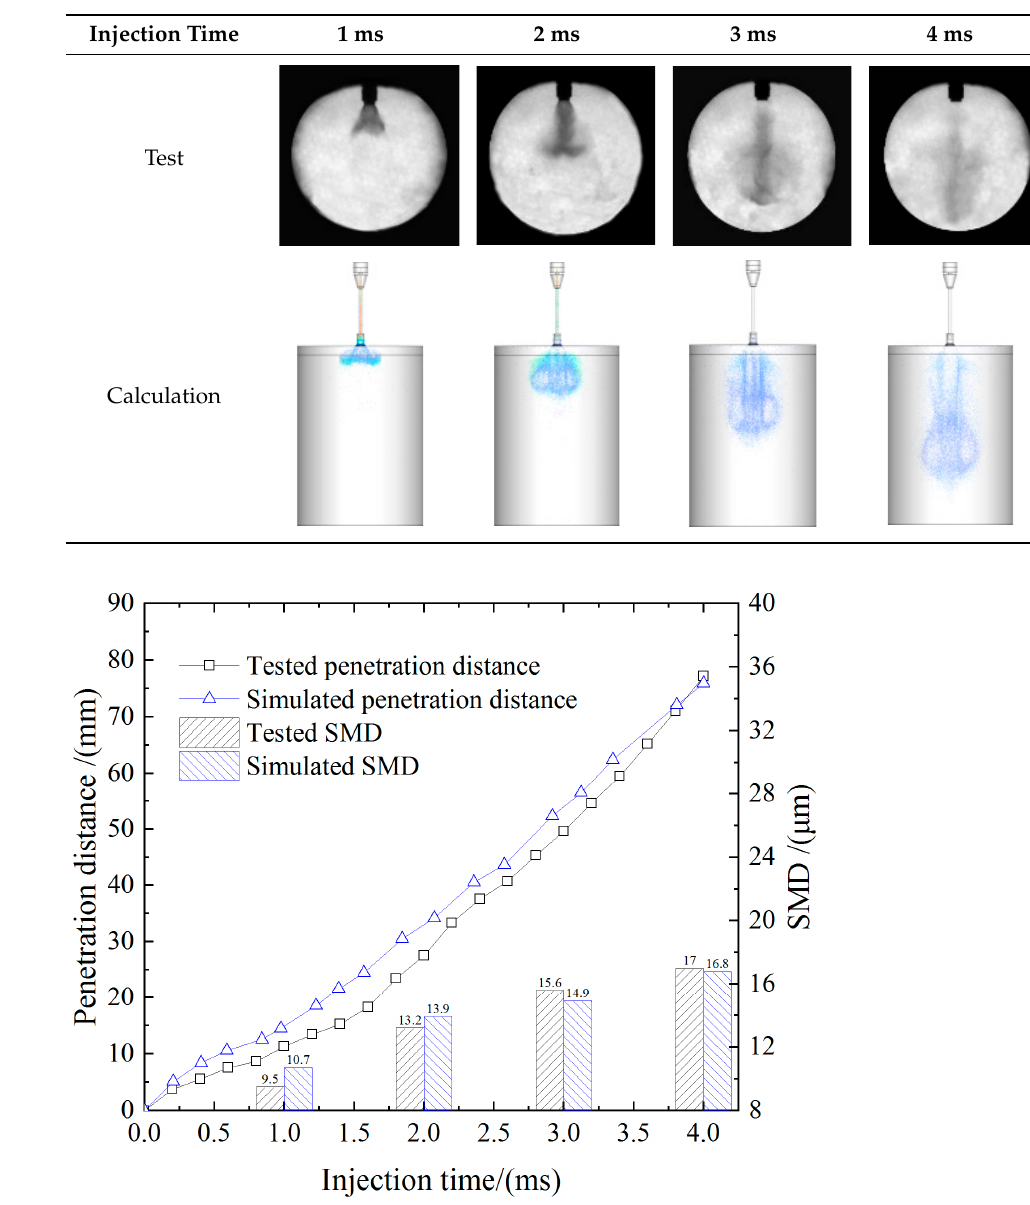
Figure 4. Comparisons of spray characteristics between the test and simulation.